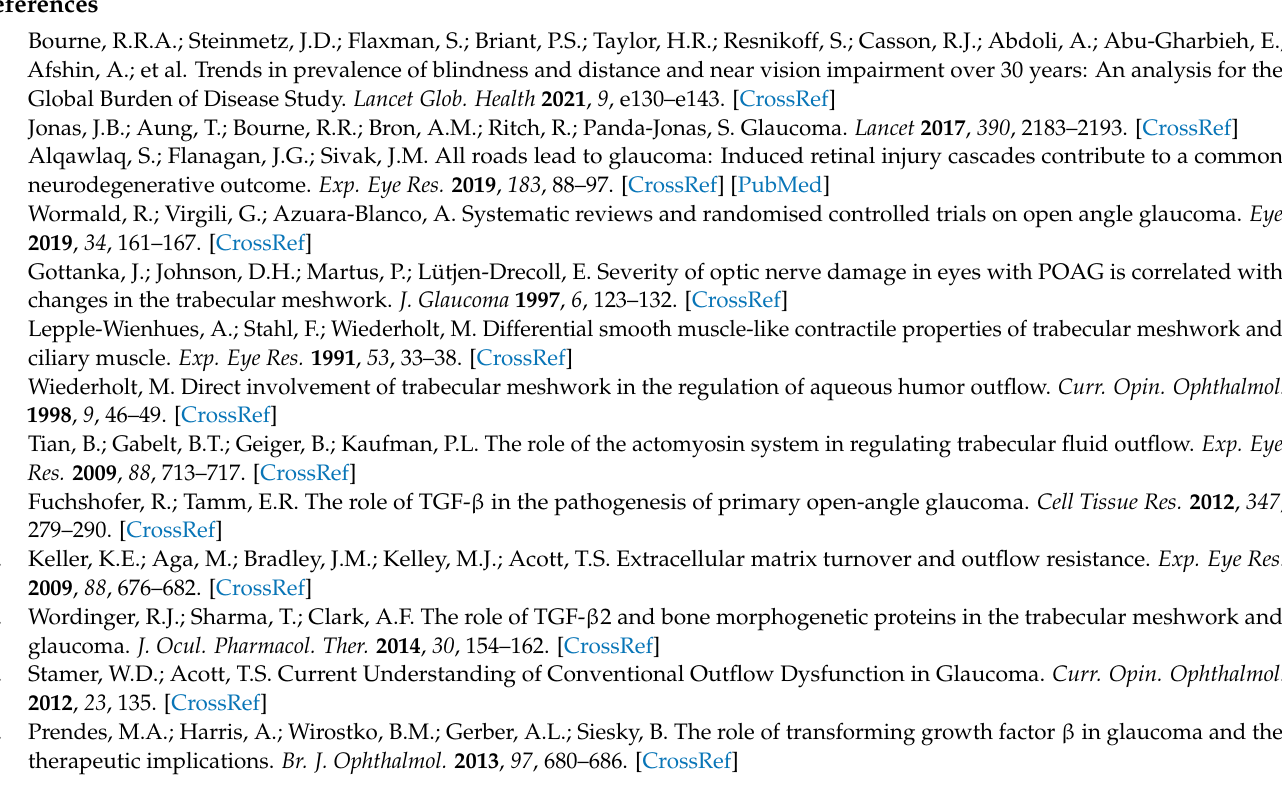
Table S2: miScript primer assay sequences; Table S3: Unlabelled gene-specific human primers; Figure S1: Characterisation of donor TM cells; Figure S2: Characterisation of TM cells from donors 4 to 11 by Western blot for myocilin; Figure S3: All Western blots for CTGF and Lamin A; Figure S4: Validation of lentiviral cell lines; Figure S5: Lentiviral-transduced TM cells display characteristic upregulation of myocilin by dexamethasone; Figure S6: Original myocilin blot images; Figure S7: Original CTGF and Lamin A blot